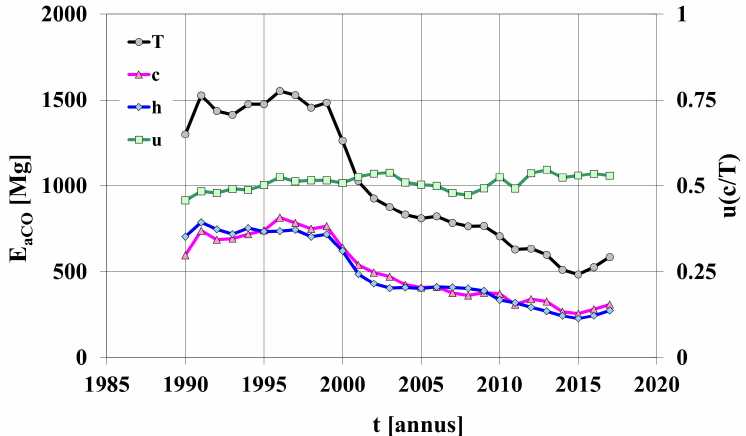
Figure 1. Annual carbon monoxide emission—E aCO : national (total)—T, from car engines at cold- start—c, from car engines at warm-up—h and the share of additional emissions during engine heating in total